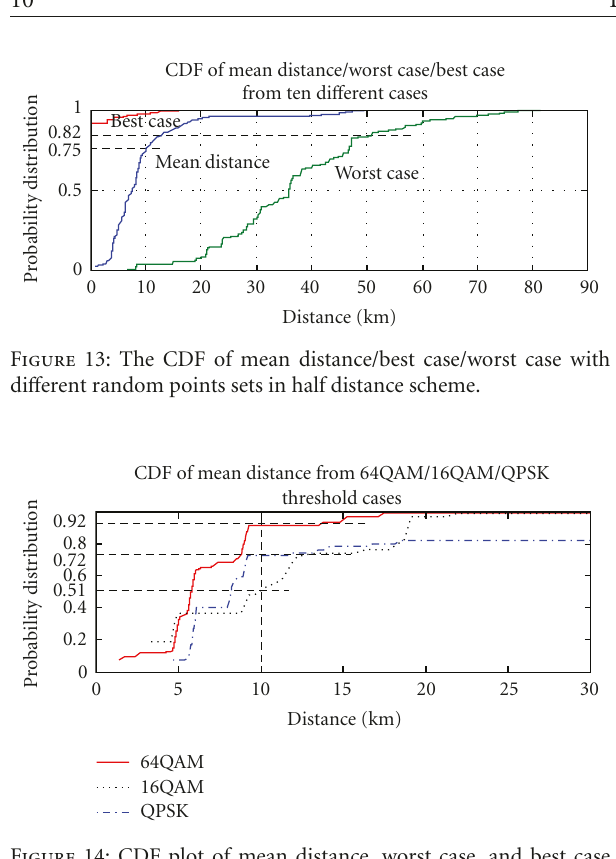
Figure 14: CDF plot of mean distance, worst case, and best case from 64 QAM, 16 QAM, and QPSK modulation scheme.